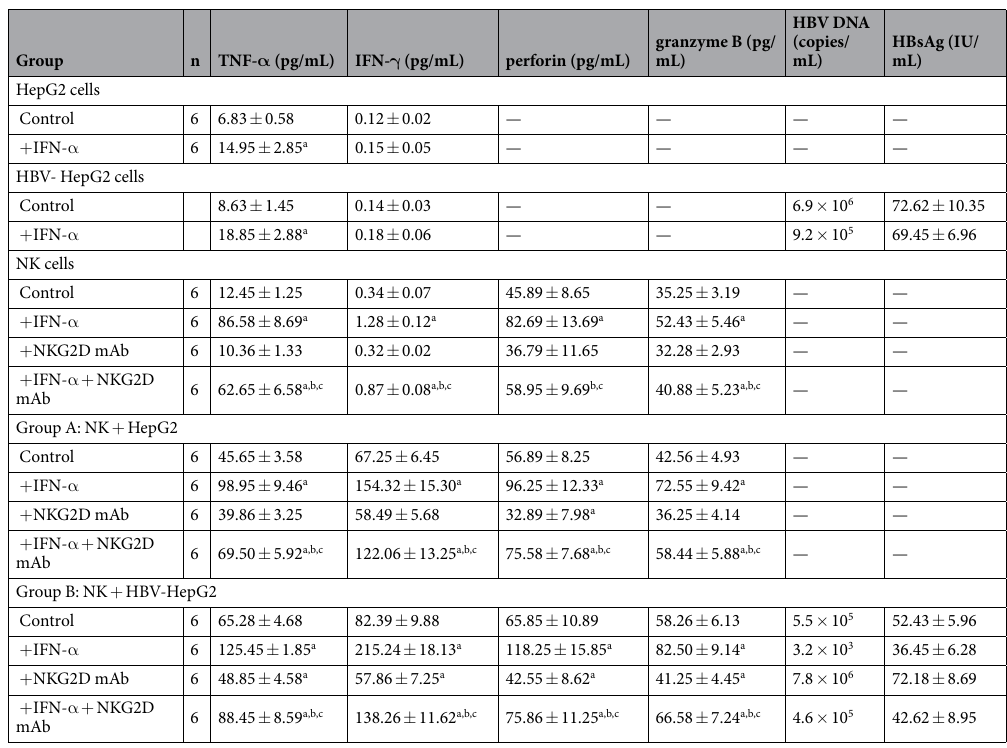
Table 2. Levels of IFN- γ , TNF- α , perforin and granzyme B in different co-cultured supernatants after addition of IFN- α alone or together with NKG2D mAb (Mean ± SD). NKG2D, NKG2 family receptor D; IFN, interferon; TNF, tumor necrosis factor; HBV hepatitis B virus; HBsAg: surface antigen of hepatitis B; a P < 0.05, compared with the control group of the same co-cultured system. b P < 0.05, compared with NK + IFN- α group of the same co-cultured system. c P < 0.05, compared with NK + NKG2D mAb group of the same co-cultured